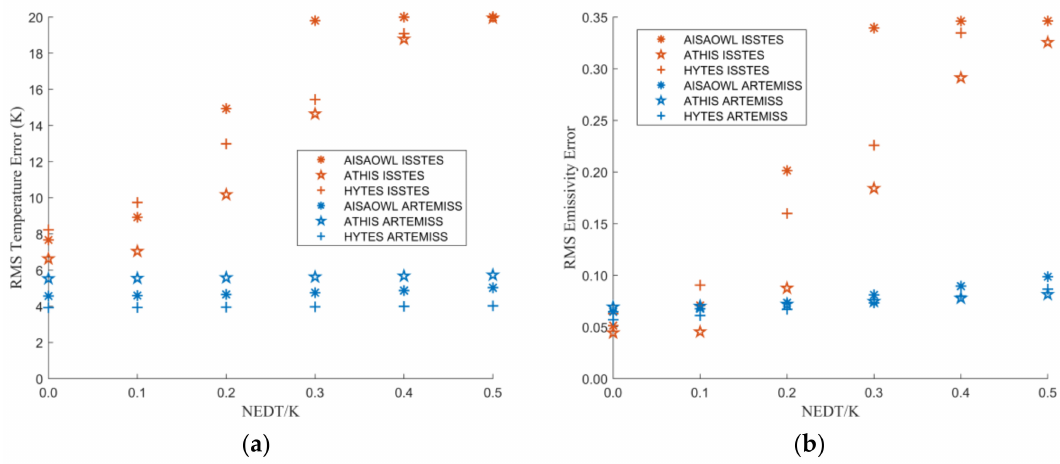
Figure 11. The graph of LST or LSE errors varying with NEDT. The X axis is NEDT, and the Y axis is LST error in ( a ) and is LSE error in ( b ).